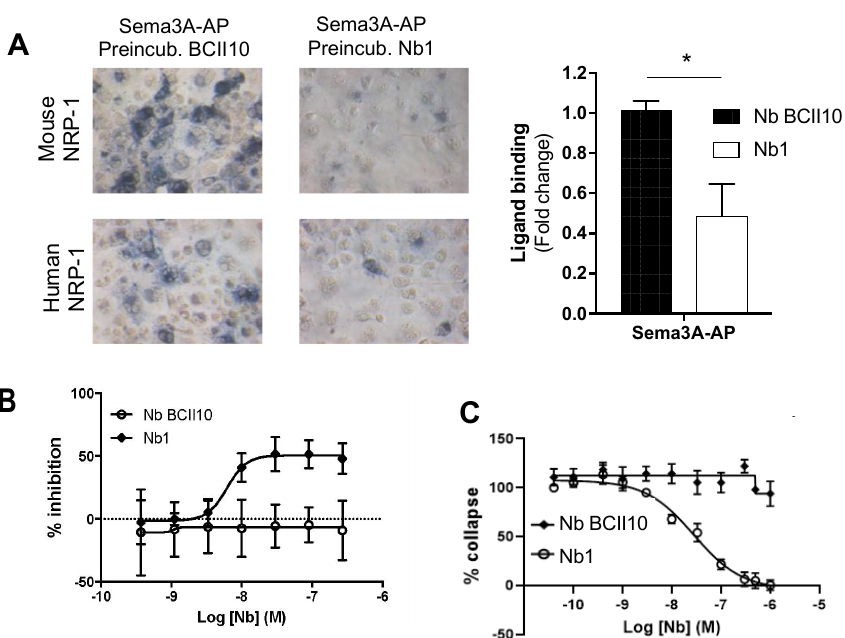
Figure 2. Nb1 interferes with the binding between NRP-1 and Sema3A. ( A ) The microscopic images show mNRP-1 + or hNRP-1 + COS cells preincubated with BCII10 or Nb1 and stained with p-nitrophenylphosphate after incubation with alkaline phosphatase (AP) conjugated Sema3A (20 × magnification). The graph on the right shows the fold change in the binding of Sema3A to human NRP-1 in the presence of Nb1 (white bar) ( n = 3). ( B ) The graphs show the result of the AlphaScreen on mouse NRP-1. The curve shows an increasing concentration of BCII10 (white dots) or Nb1 (black squares) competing with Sema3a-Fc for binding with biotinylated NRP-1 ( n = 3). ( C ) The graph shows the percentage reduction in cell area (µm 3 ) of human umbilical vein endothelial cells (HUVECs) treated for 30 min with an increasing concentration of Nb1 (black dots) or BCII10 (black squares), followed by a Sema3a-Fc incubation of 30 min ( n = 3). Statistical analysis was performed by the Student’s t -test and asterisks represent a p -value < 0.05 (*).